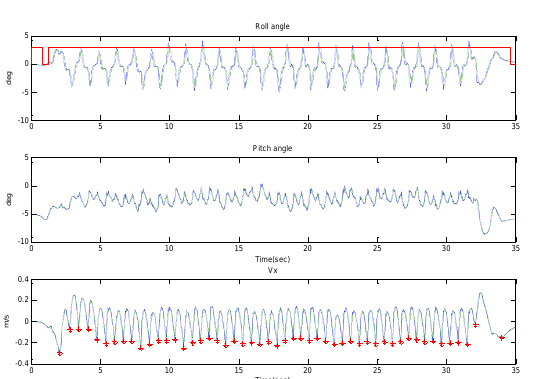
Figure 9. The scheme of the proposed pedestrian navigation